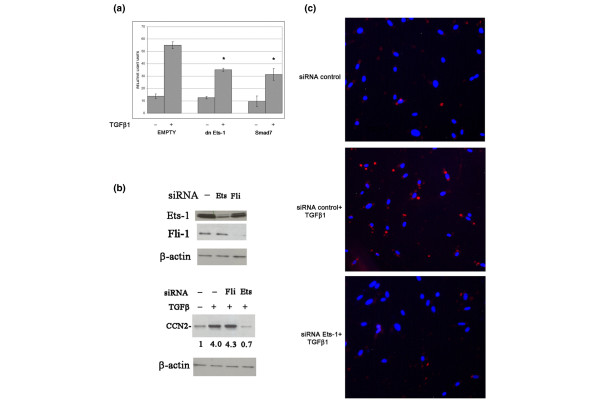
Ets-1 is required for the transforming growth factor (TGF)β induction of CCN2. (a) Dominant negative Ets-1 blocks the TGFβ induction of the CCN2 promoter. A CCN2 promoter/reporter construct driven by nucleotides -805 to +17 of the CCN2 promoter was transfected into fibroblasts along with empty expression vector or expression vector encoding dominant negative Ets-1 or Smad7, as indicated. Following serum starvation for 24 hours, cells were incubated in the presence or absence of 4 ng/ml TGFβ1 for 24 h, as indicated. Average ± standard deviation (N = 6) is shown (*p < 0.05). (b) Small interfering RNA (siRNA) recognizing Ets-1 mRNA suppresses the TGFβ induction of CCN2. Western blot analysis; fibroblasts were transfected either with control siRNA or siRNA recognizing Ets-1 or Fli-1 mRNAs. Following a serum starvation step of 24 h, cells were incubated in the presence or absence of a 4 ng/ml TGFβ1 for 24 h, as indicated. Proteins were blotted onto nitrocellulose, Membranes were probed with anti-Ets-1, anti-Fli-1 or anti-CCN2 antibodies, as indicated. Values below CCN2 western blot indicate relative amounts of CCN2 protein as determined by densitometry relative to actin. (c) siRNA recognizing Ets-1 mRNA suppresses the TGFβ-induction of CCN2. Immunofluorescence analysis; fibroblasts were transfected either with control siRNA or siRNA recognizing Ets-1. After a serum starvation step of 24 h, cells were incubated in the presence or absence of 4 ng/ml TGFβ1 for 24 h, as indicated. Cells were then fixed in paraformaldehyde, and CCN2 was detected with an anti-CCN2 antibody followed by incubation with an appropriate Texas Red-conjugated secondary antibody (red). Cells were costained with DAPI to detect nuclei (blue).